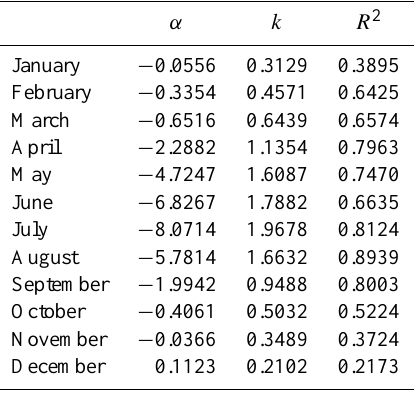
Table 1. Monthly Blaney–Criddle parameters fitted for GB to repro- duce 40km MORECS spatial pattern of long-term mean monthly PET (186 grid cells were used). The R 2 statistic gives a measure of the goodness of